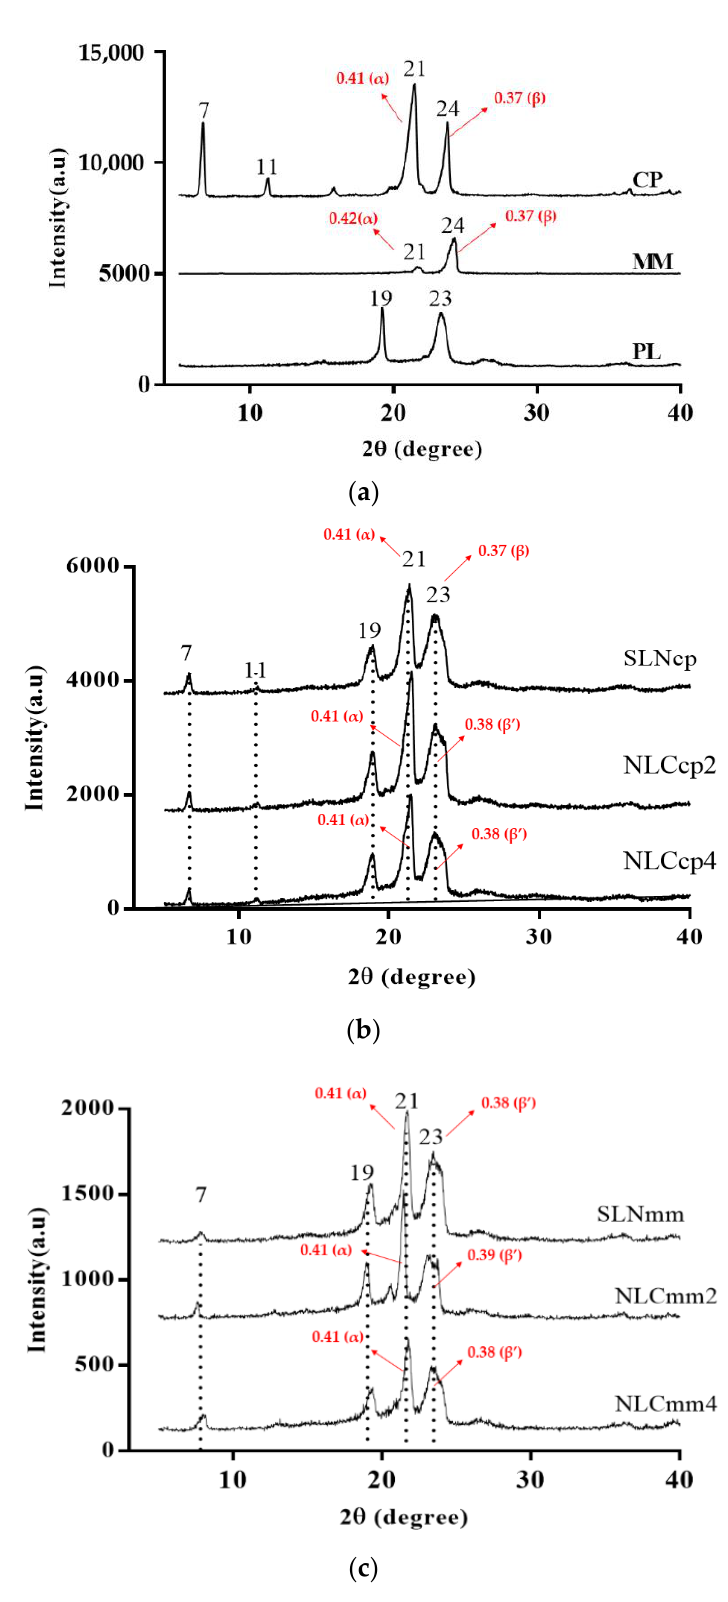
Figure 6. Diffractograms of raw material ( a ) used to produce cetyl palmitate ( b ) and myristyl myristate ( c ) nanoparticles. Note: α : d = 0.41–0.42 nm, β : d = 0.46 nm, β ’: 0.42 < d < 0.43 nm or 0.37 < d < 0.40 nm (main reflections and lattice spacings of the CP, MM and SLN/NLC calculated by Bragg equation data are presented in Supplementary Materials, Table